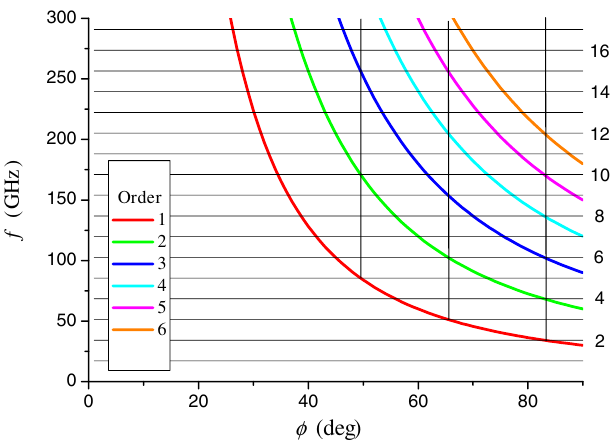
FIG. 7. (Color) Frequency f (GHz) vs emission angle (cid:3) ( (cid:6) ) for the lowest six orders of SP radiation in the MIT experiment. Coherent SP radiation is expected at angles where an order curve intersects a harmonic (indicated at right) of the bunch frequency, 17.14 GHz.